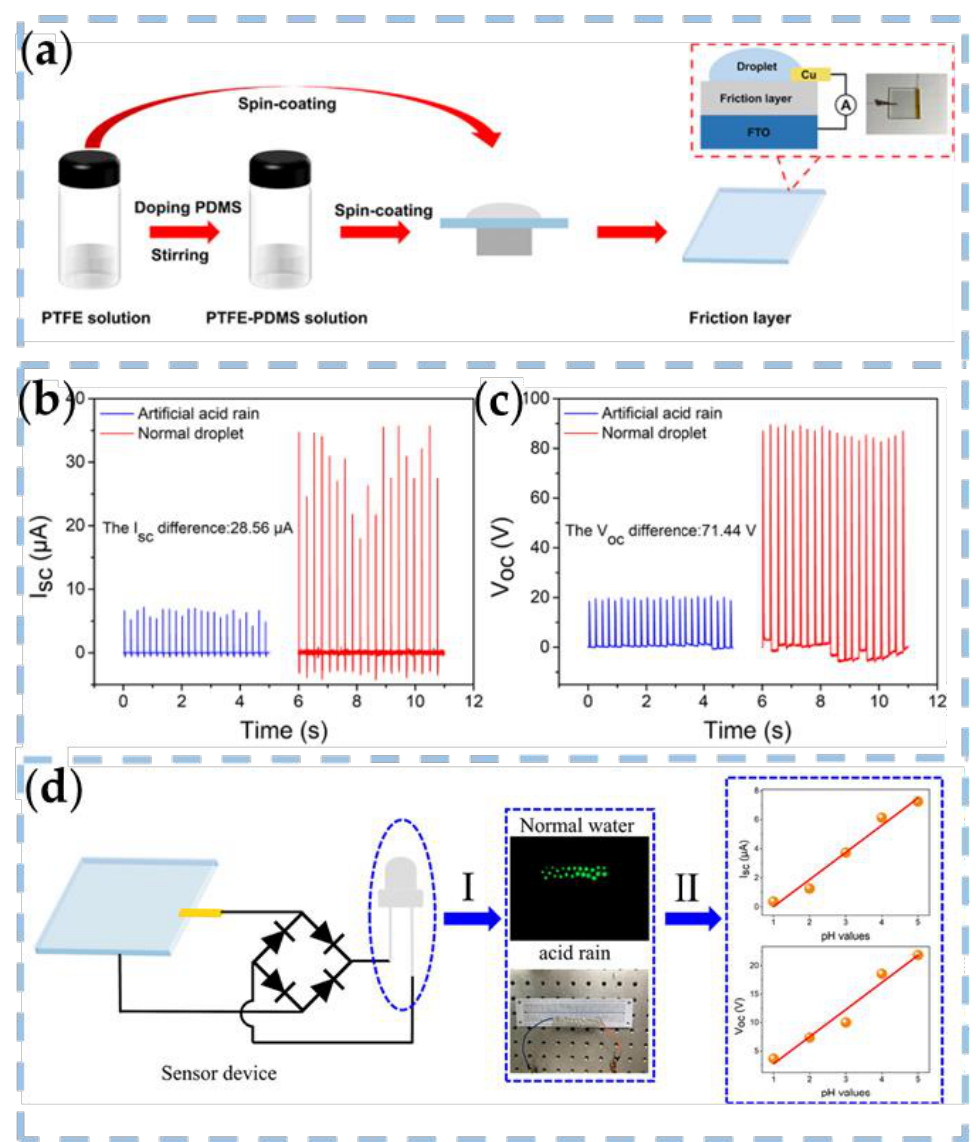
Figure 7. ( a ) Preparation process of the friction layer, the structure of the TENG device, and a real-time photograph of the sensor based on the D-TENG. ( b , c ) Differences in output performance when artificial acid rain and standard water droplets impinge on the optimized D-TENG. ( d ) Circuit diagram for detecting acid rain with the TENG sensor. Section 1 represents the visual determination of typical and acid rainwater droplets, and Section 2 illustrates the estimation of the pH value of acid rain [80] . Copyright 2021, AMER CHEMICAL SOC.